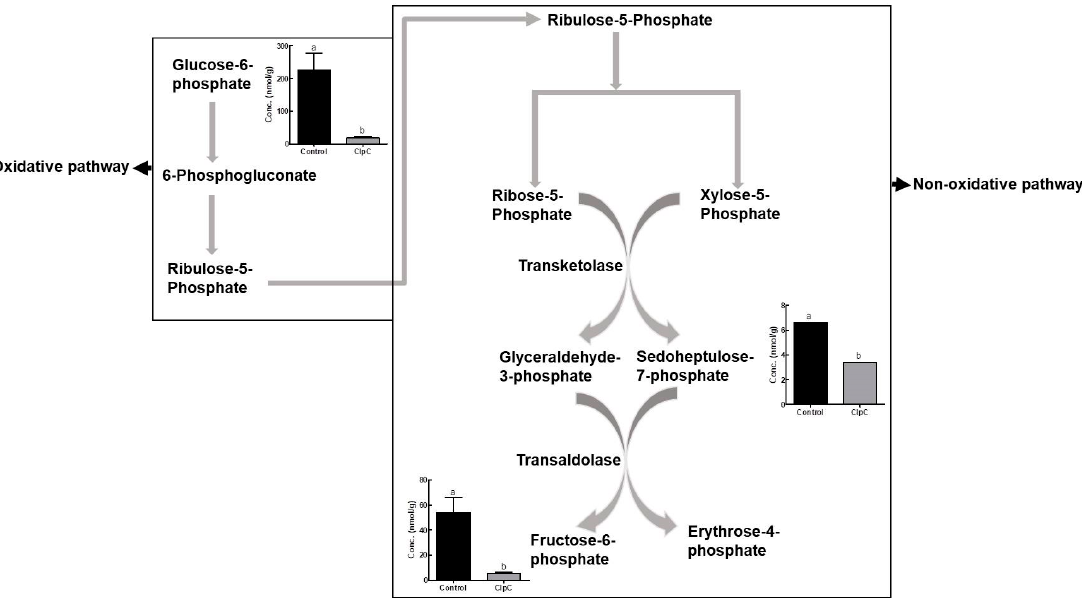
Figure 4. Comparison of pentose phosphate pathway-related (oxidative and nonoxidative) metabolite contents in Nicotiana benthamiana plants with co-suppression of NbClpC1/C2. ClpC: NbClpC1/C2 co-suppressed plants. The error bars indicate the SD of triplicate samples. The different letters on the bars indicate statistically significant differences between groups ( p <0.05).